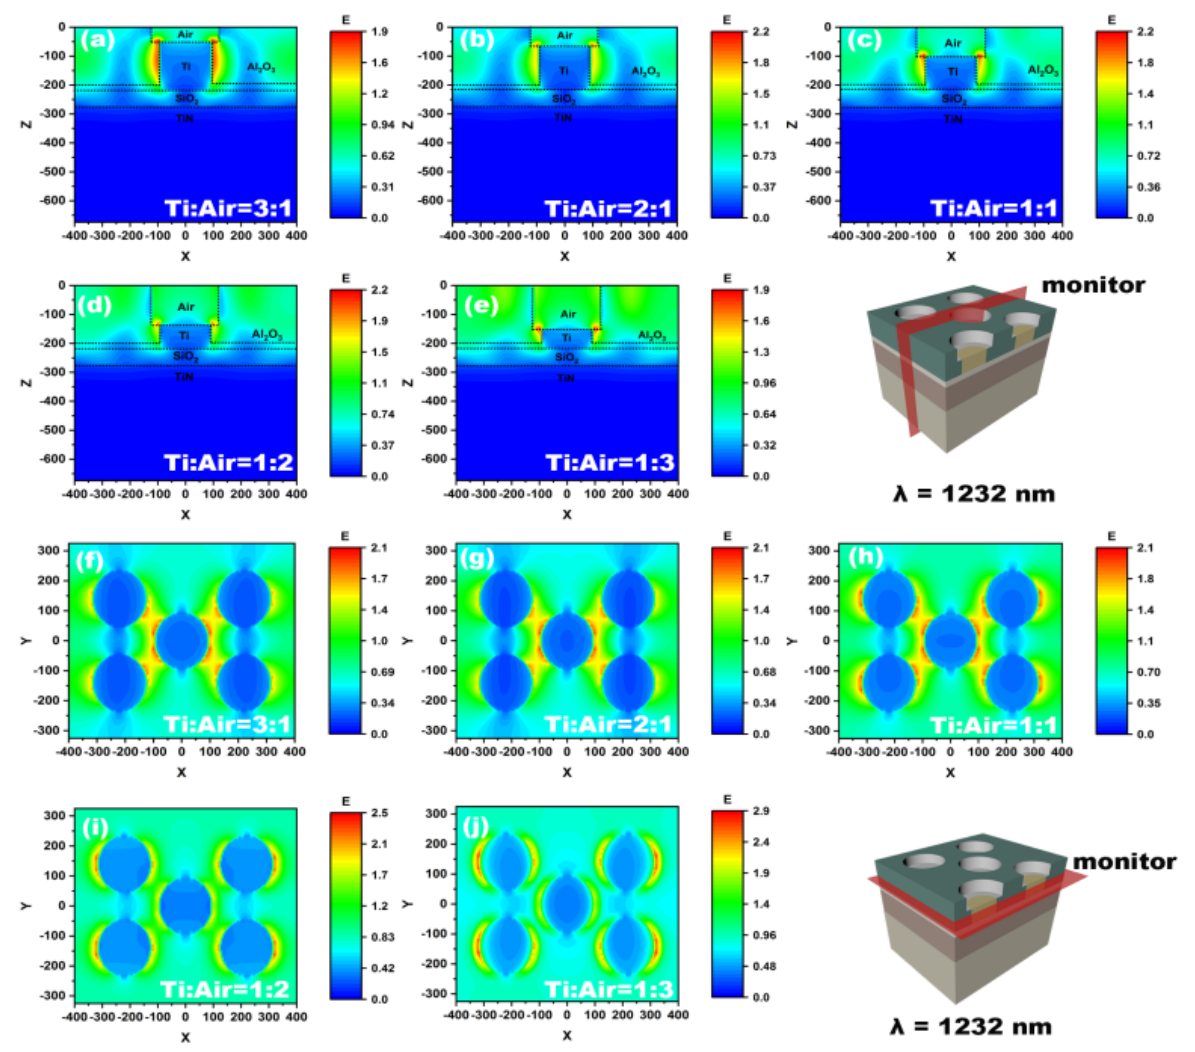
Figure 8. Distribution of electric field in the XZ cross-section ( a − e ) and XY cross-section ( f − j ) of absorber with different volume ratios at 1232 nm. The monitor in XY plane is set at the interface between Al 2 O 3 and Ti thin film.